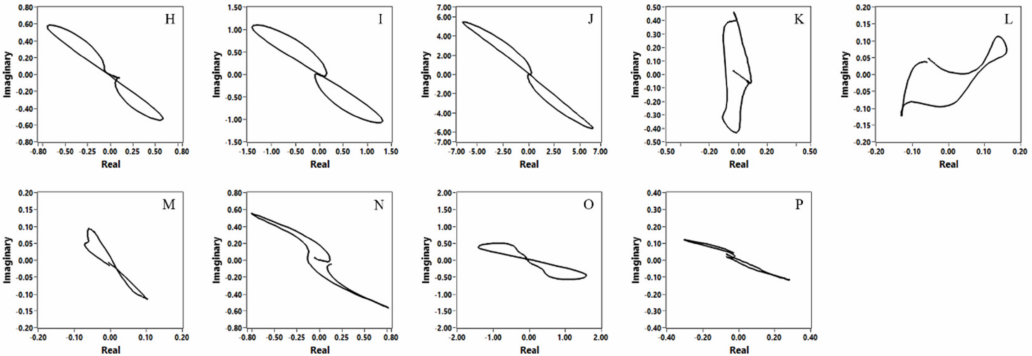
Figure 12. Lissajous curves from the front bobbin coils for the specimen with multisite flaws (150 kHz